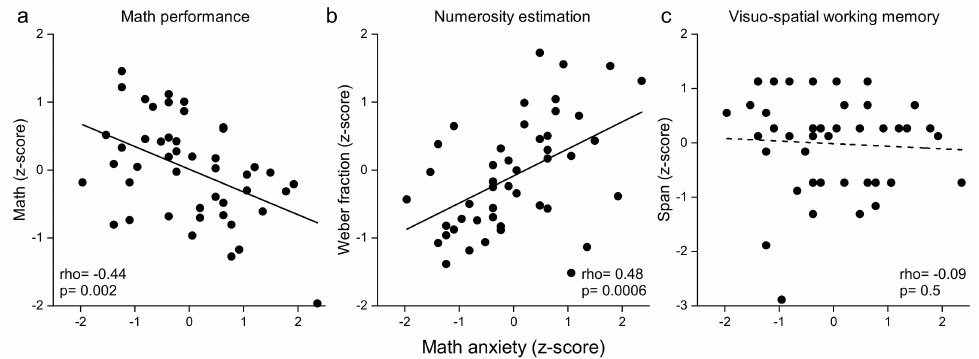
Figure 2. Correlations between math anxiety, formal math performance ( a ), numerosity estimation acuity (Weber fraction, ( b )), and VSWM scores (span, ( c )). Lines represent best linear fitting; dots represent individual participant scores. p < Bonferroni corrected α = 0.05/10 =